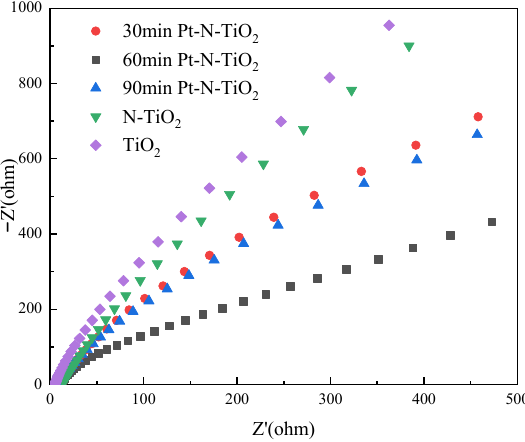
Figure 6. EIS pattern of each nanotube.